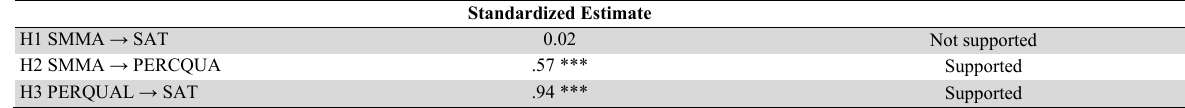
Standardized Estimate